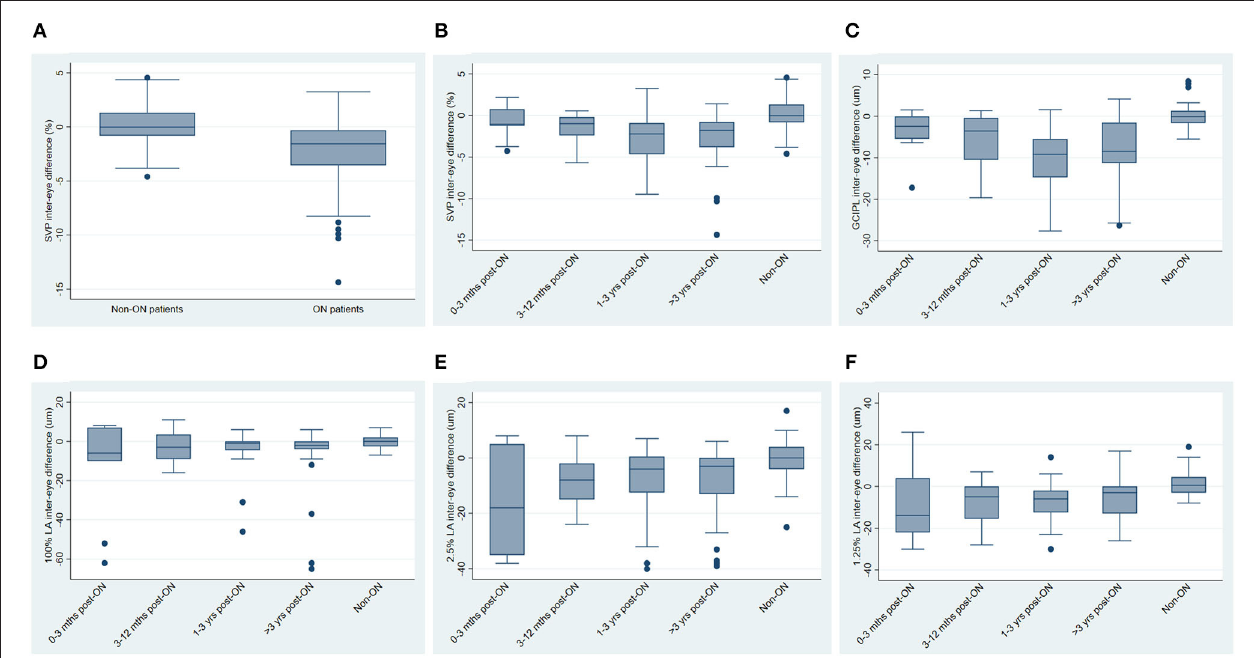
FIGURE 2 | Inter-eye differences in SVP density, GCIPL thickness and visual function, stratified by history of optic neuritis . (A) Inter-eye differences in SVP density in MS non-ON patients vs. MS ON patients. (B) Inter-eye differences in SVP density in MS ON patients stratified by time from ON, vs. MS non-ON patients. (C) Inter-eye differences in GCIPL thickness in MS ON patients stratified by time from ON, vs. MS non-ON patients. (D–F) Inter-eye differences in 100% contrast letter acuity (D) , 2.5% contrast letter acuity (E) , and 1.25% contrast letter acuity (F) in MS ON patients stratified by time from ON vs. MS non-ON patients.